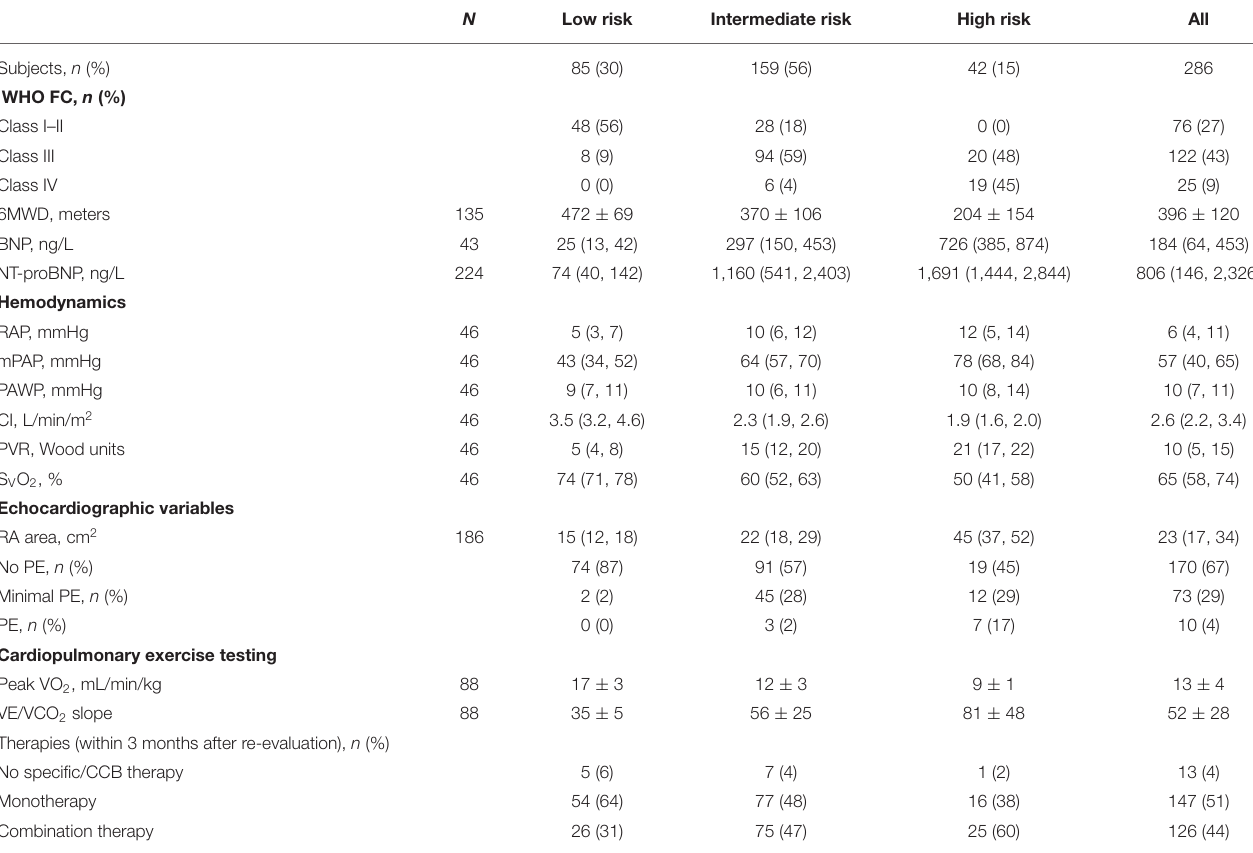
TABLE 3 | Characteristics of patients with IPAH in re-evaluation risk stratification. N Low risk Intermediate risk High risk